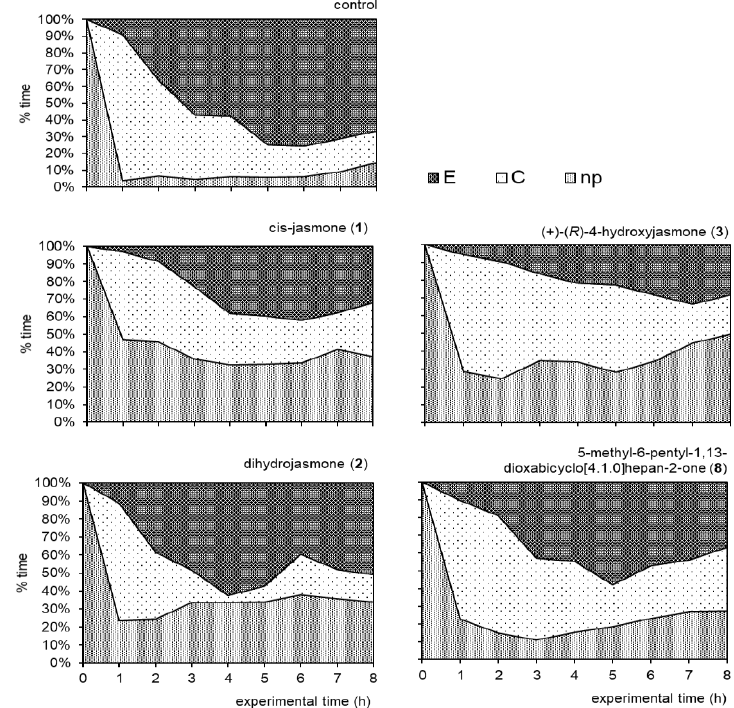
Figure 2. Feeding success of Myzus persicae on Brassica rapa subsp. pekinensis exposed to cis- jasmone ( 1 ), dihydrojasmone ( 2 ) and derivatives: (+)-( R )-4-hydroxyjasmone ( 3 ), (+)-( R )-4-hydroxydihydrojasmone ( 4 ), 7,8-epoxyjasmone ( 5 ), 4-hydroxy-7,8-epoxyjasmone ( 6 ), 3,4-dihydro-5-methyl-6-pentyl-2 H -pyran-2- one ( 7 ), 5-methyl-6-pentyl-1,13-dioxabicyclo[4.1.0]hepan-2-one ( 8 ), (-)-5-hydroxy-5-methyl-6-pentyltetrahydro-2 H -pyran-2-one ( 9 ), and 5-methyl-6-pentyl-1,13-dioxabicyclo[4.1.0]heptan-2-ol ( 10 ). The same plant species was used to maintain the aphid stock culture.